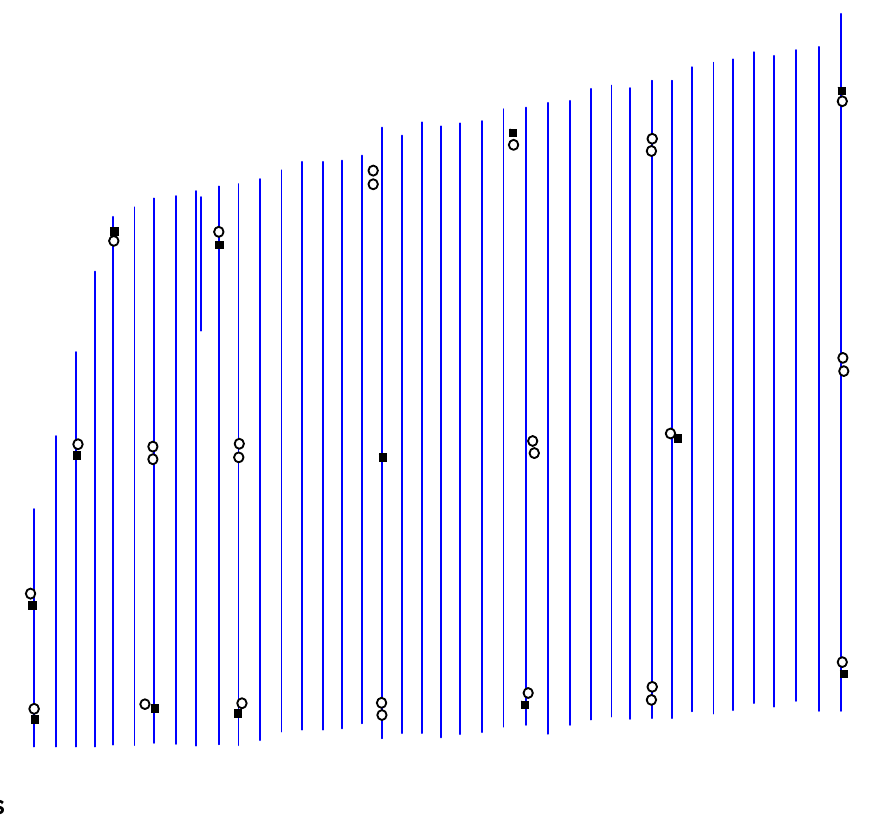
Figure 2. Distribution of flight lines, GCPs and check points of an ADS40 project with 41 strips. ■ means control point, ○ means check